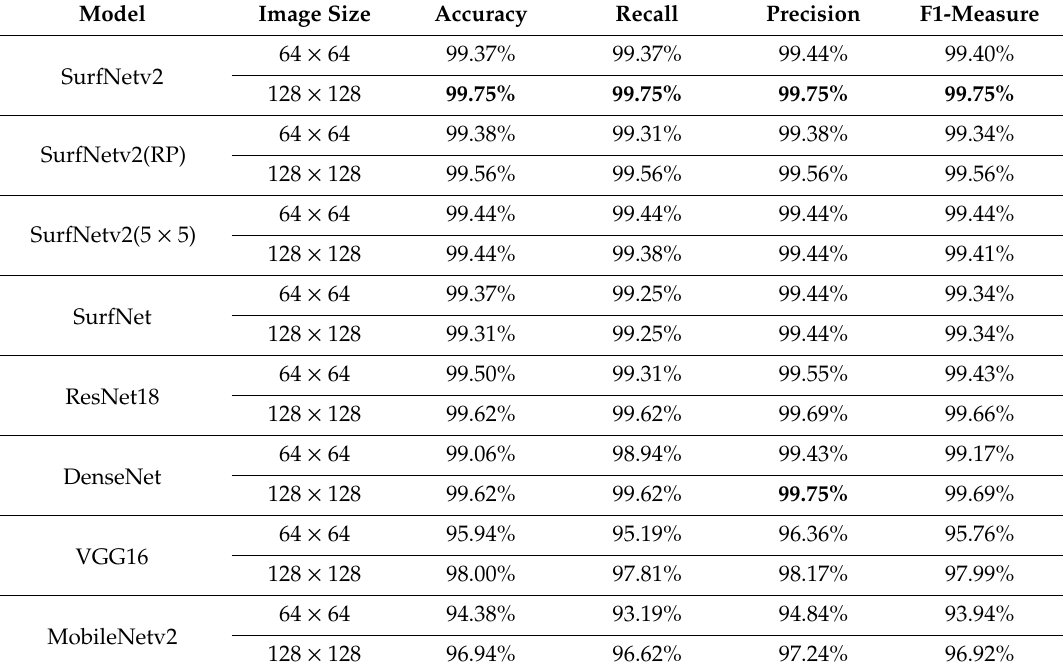
Table 7. Experiment results of the public NEU